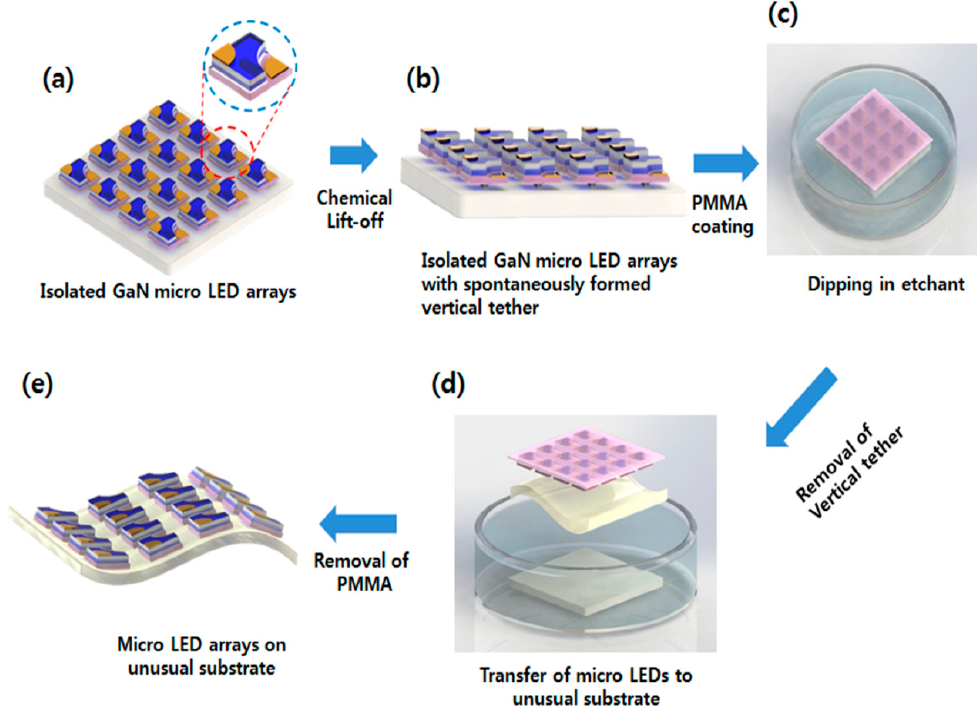
Figure 1. Schematic illustrations and images corresponding to steps for the transfer of Gallium nitride (GaN) light emitting diodes (LEDs): ( a ) isolated microLED arrays, ( b ) Isolated GaN micro LED arrays with spontaneously formed vertical tether, ( c ) deposition of PMMA and removal of remaining pillars, and ( d ) transfer of microLED arrays to unusual substrate. ( e ) MicroLED arrays on an unusual substrate.